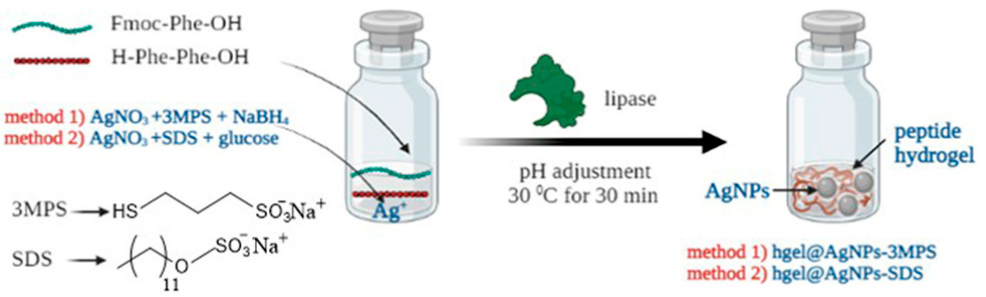
Figure 1. Scheme of the preparation of hgel@AgNPs composites.